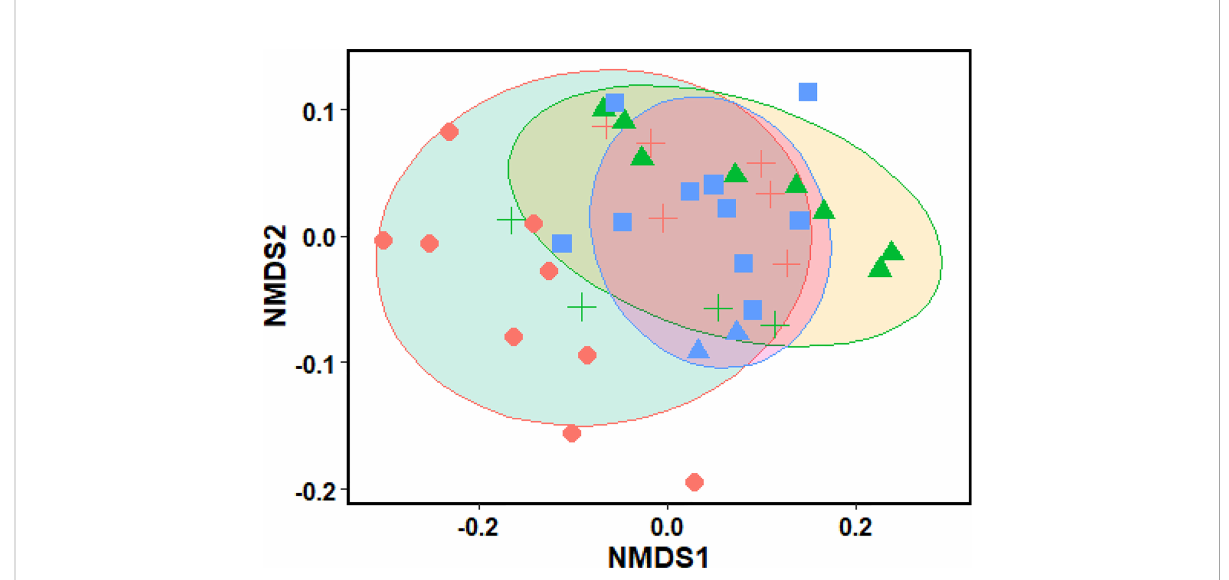
FIGURE 3 Distribution of sites in two-dimensional NMDS ordinations (stress = 0.04%) based on shrub environmental variables and trait plasticity for Calotropis procera. Ellipsis (Altitude), different symbols (biomass variation at different aspect degree), ellipsis color (slope